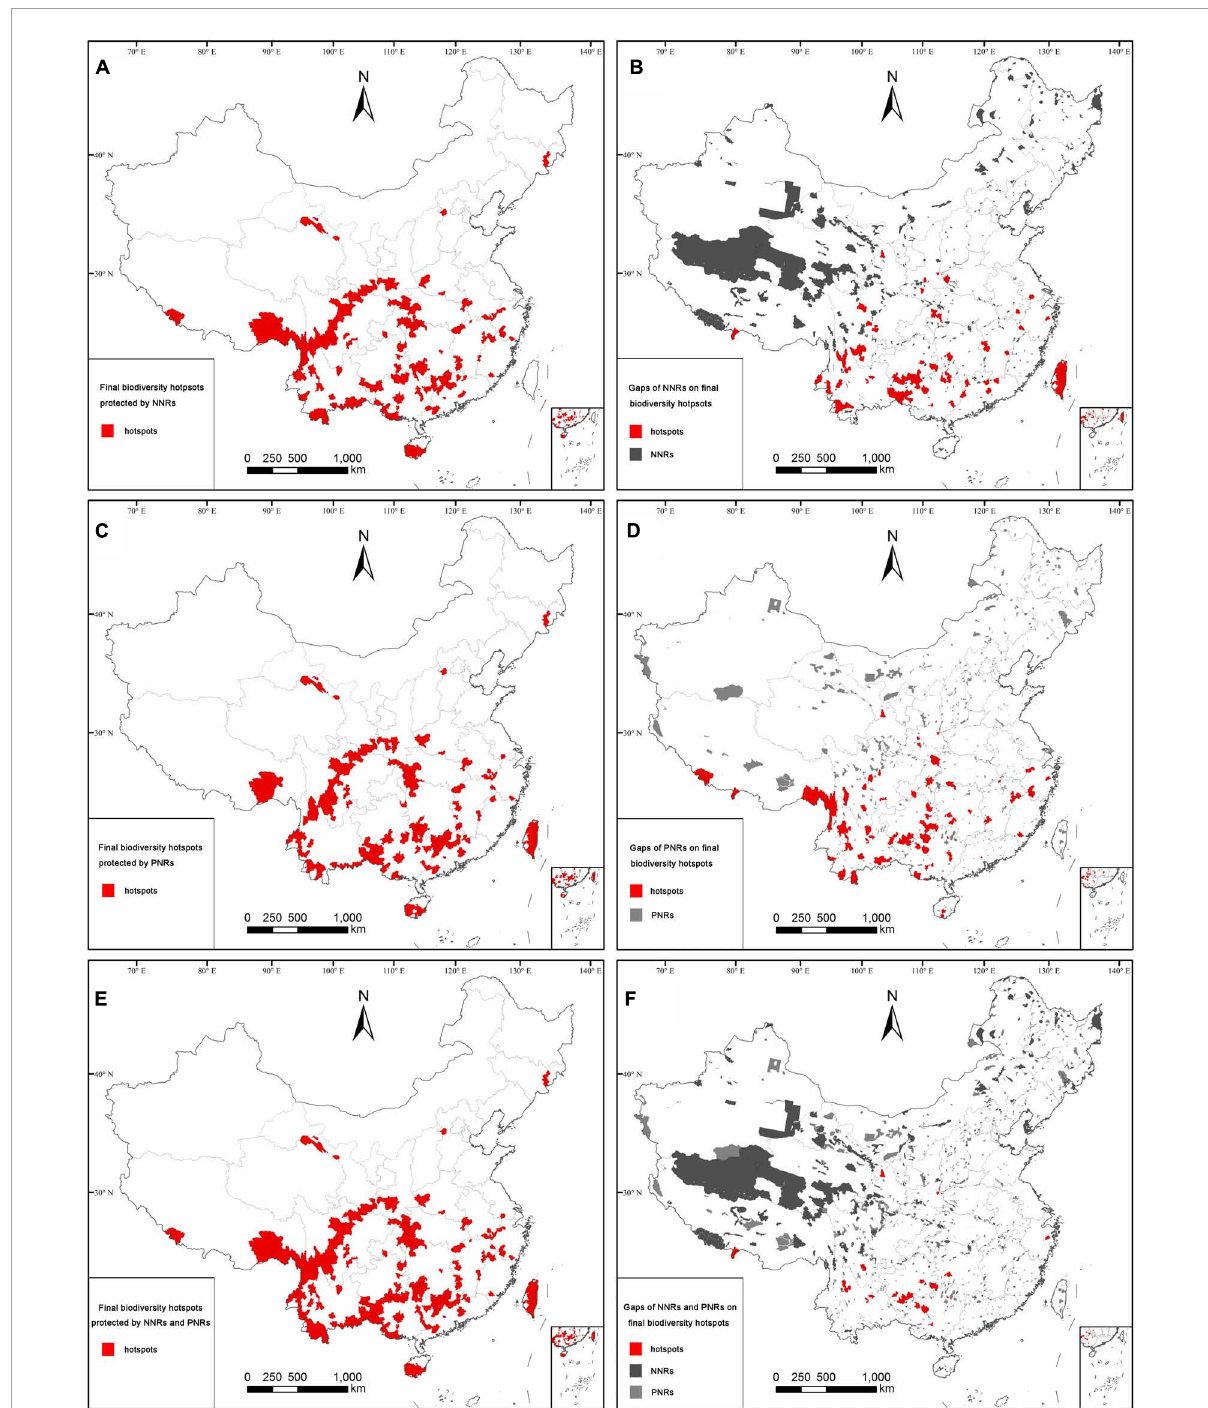
FIGURE5 Conservation effectiveness and gaps in the final biodiversity hotspots of seed plant species in the current conservation network: conservation effectiveness of NNRs (A) , PNRs (C) , and NNRs and PNRs (E) ; conservation gaps of NNRs (B) , PNRs (D) , and NNRs and PNRs (F) .